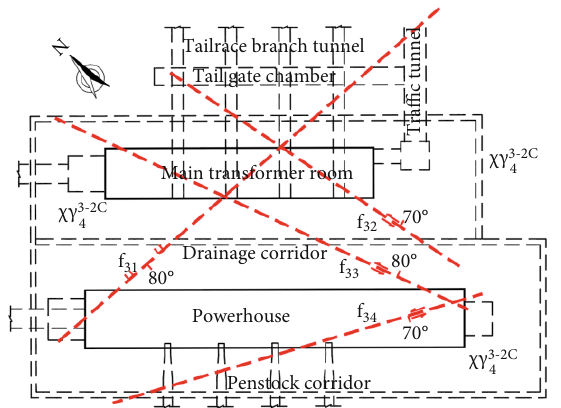
Figure 1: Planar graph of underground powerhouse area at elevation 172.60m.